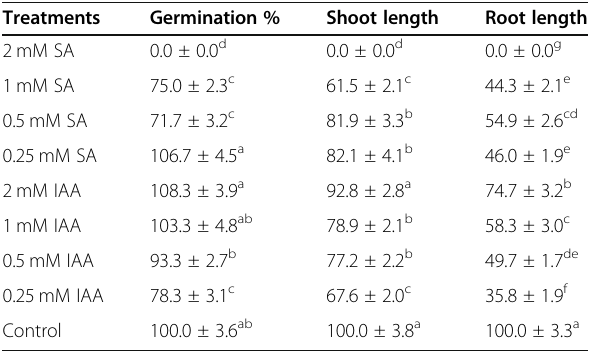
Table 3 Impact of SA and IAA pre-soaking seeds